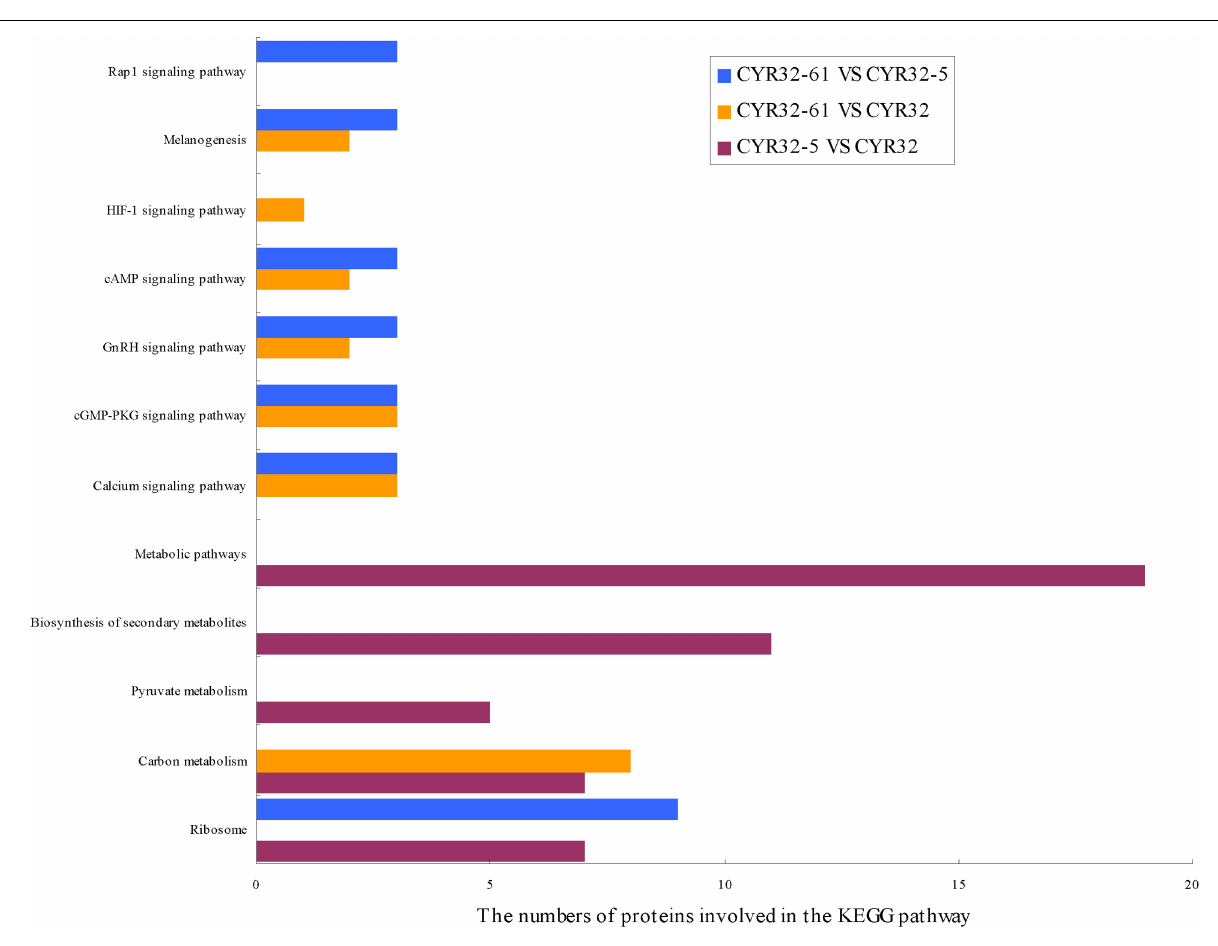
FIGURE 3 | KEGG pathway enrichment of the differentially expressed proteins acquired in the combinations CYR32-5 vs. CYR32, CYR32-61 vs. CYR32, and CYR32-61 vs. CYR32-5 ( P < 0.05).